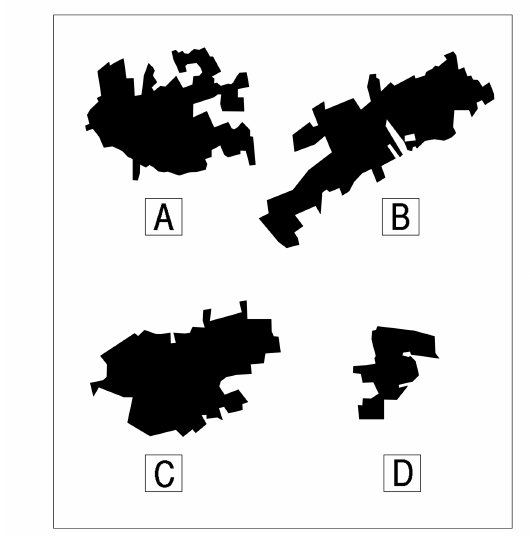
Fig. 6. Calculation example: four forest patches in the Belgian Campine region (Biological Value map 24